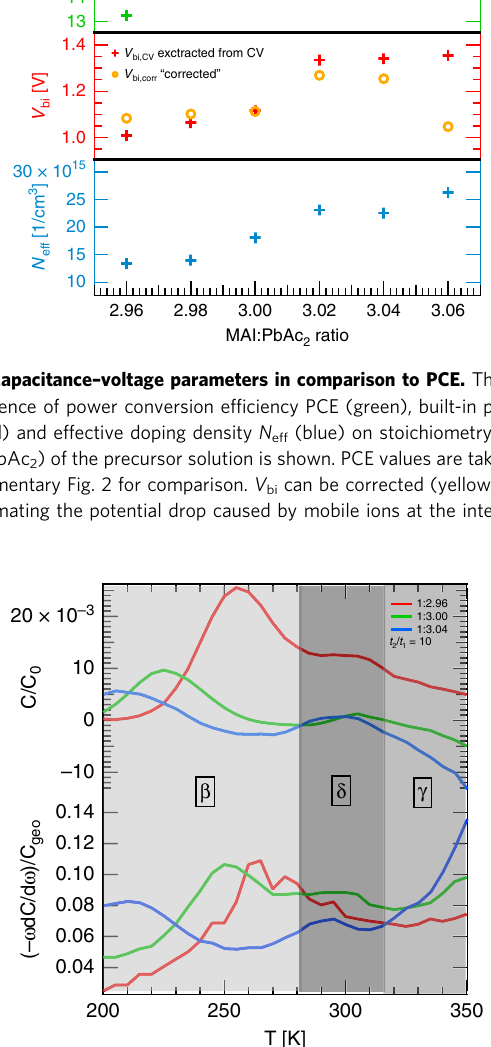
Fig. 2 Comparison of DLTS and IS spectra. DLTS spectra (top) and IS spectra (bottom) for the samples with precursor stoichiometry: 2.96 (red), 3.00 (green) and 3.04 (blue) are shown. Areas are shaded differently in order to highlight where each defect ( β , γ , and δ ) is observable. Defect γ is not completely visible for the chosen rate window t 2 / t 1 = 10. For a more detailed overview see Supplementary Figs. 5 and